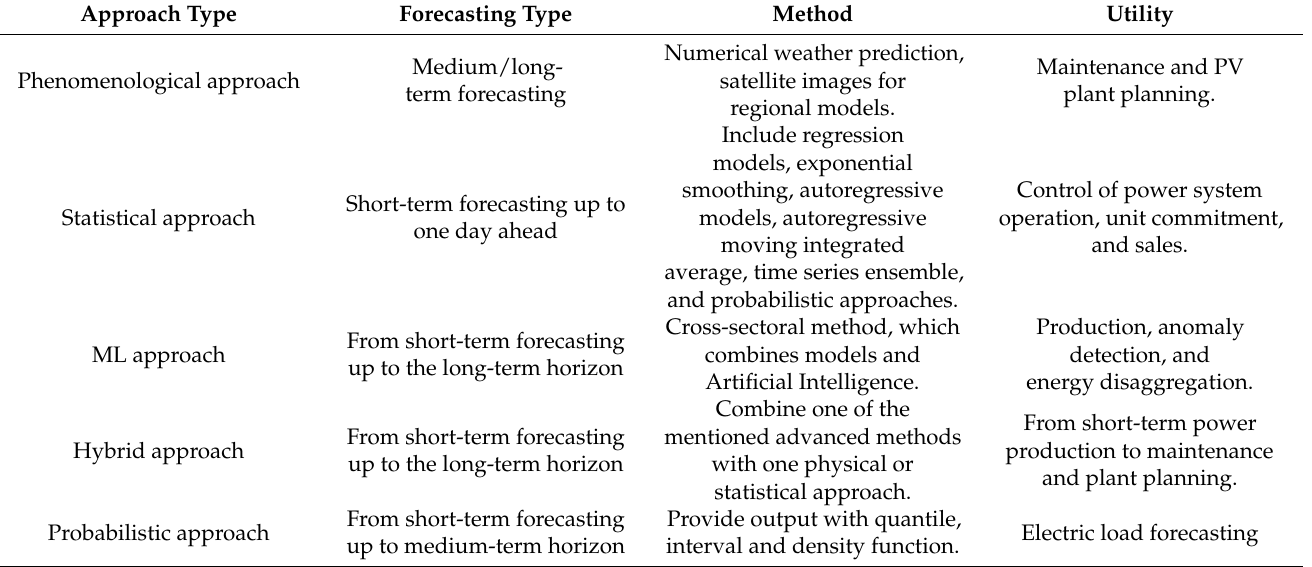
Table 1. Forecasting type, method, and utility based on the different approaches for predic- tions